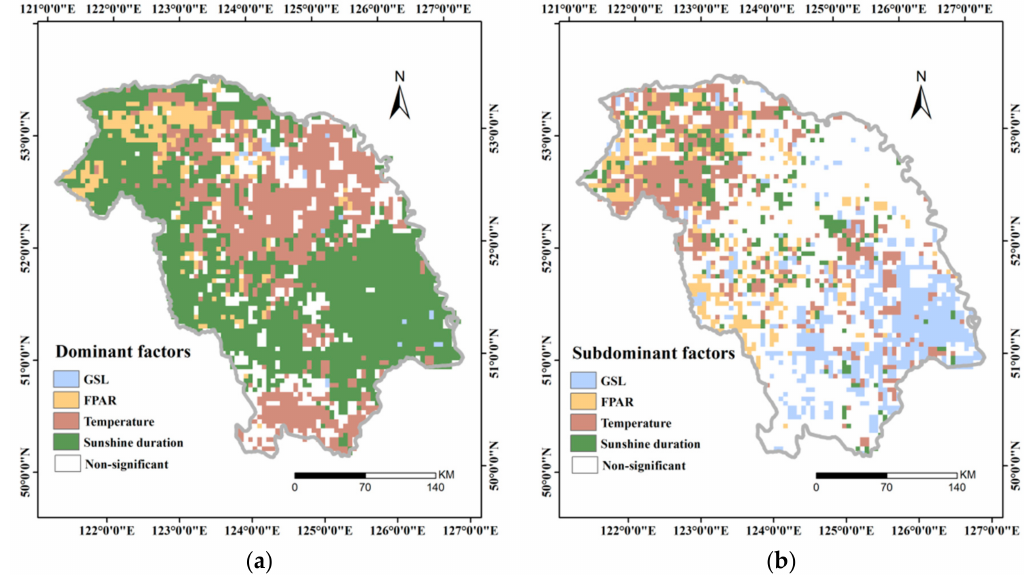
Figure 10. Spatial distribution of ( a ) dominant and ( b ) subdominant factors for AGG in the GKM from 1982 to 2015 (Non-significant means that there is no significantly effective factor for AGG among these five driving factors according to the F -test and t -test. A significant F -test was under p < 0.05, and a significant t -test was under the absolute value of t ≥